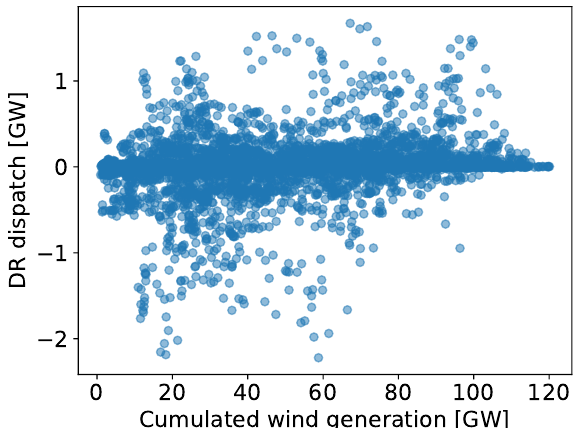
Figure 5. Correlation of the DR dispatch and the cumulated wind generation (each point represents one hour of the